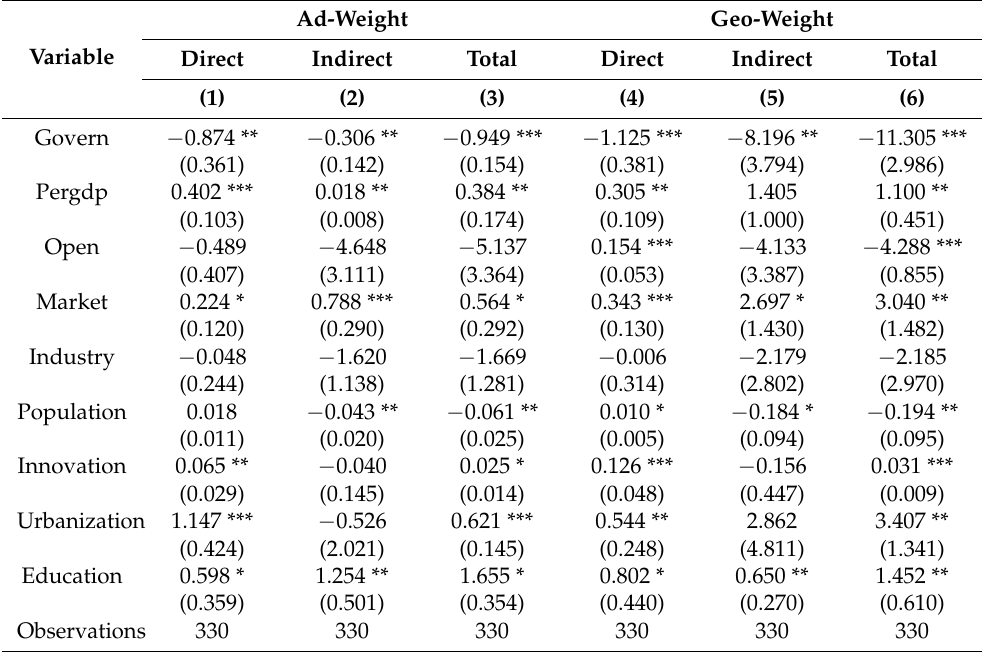
Table 6. Decomposition results of spatial